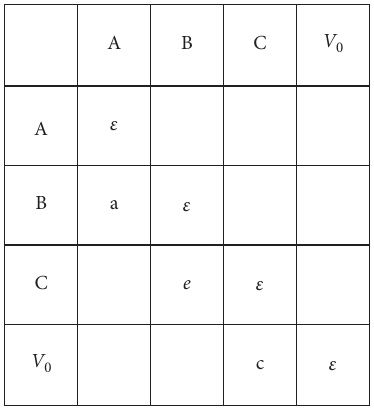
Figure 7: Matrix T p (other elements ε are